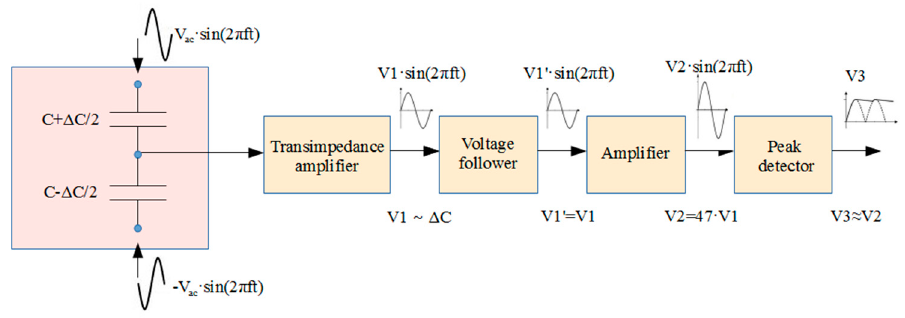
Figure 13. Operating principle of the designed external readout